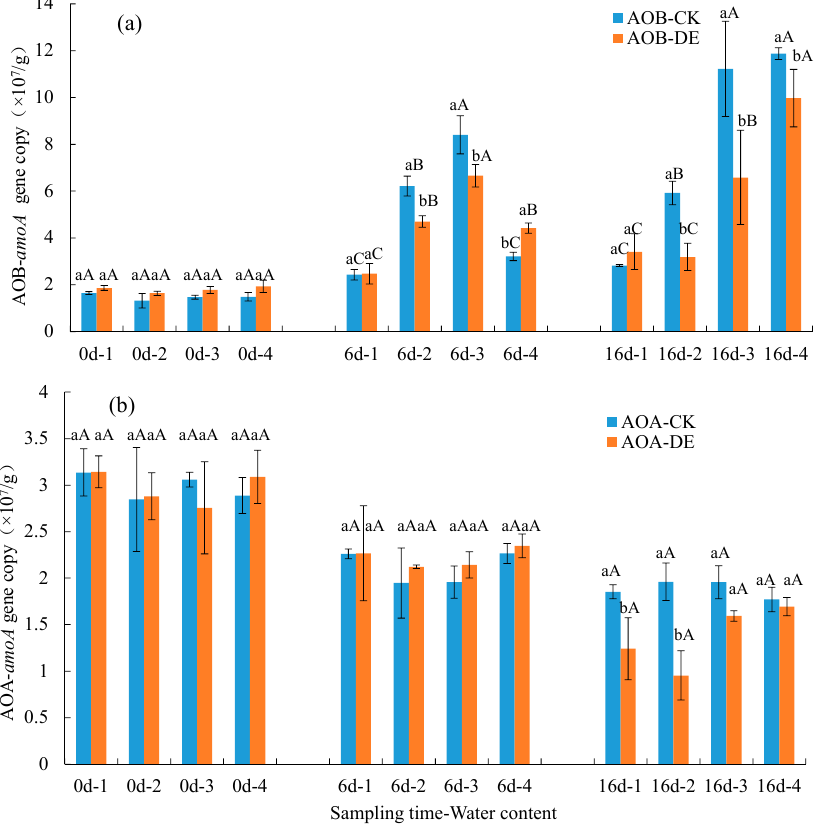
Figure 3. Characteristics of the amoA gene abundance of ammonia-oxidizing microorganisms under different treatments. Note: ( a ) ammonia-oxidizing bacteria (AOB), ( b ) ammonia-oxidizing archaea (AOA). Different lowercase letters above the columns indicate significant differences under different water types with the same moisture content ( p < 0.05), and different capital letters above the columns indicate significant differences under the same water type with different moisture contents ( p < 0.05). θ FC , soil water content at field capacity; CK, ordinary water and DE, ionized water. In the treatment labels: d, day; 1, 30% θ FC ; 2, 60% θ FC ; 3, 100% θ FC and 4, 175% θ FC .